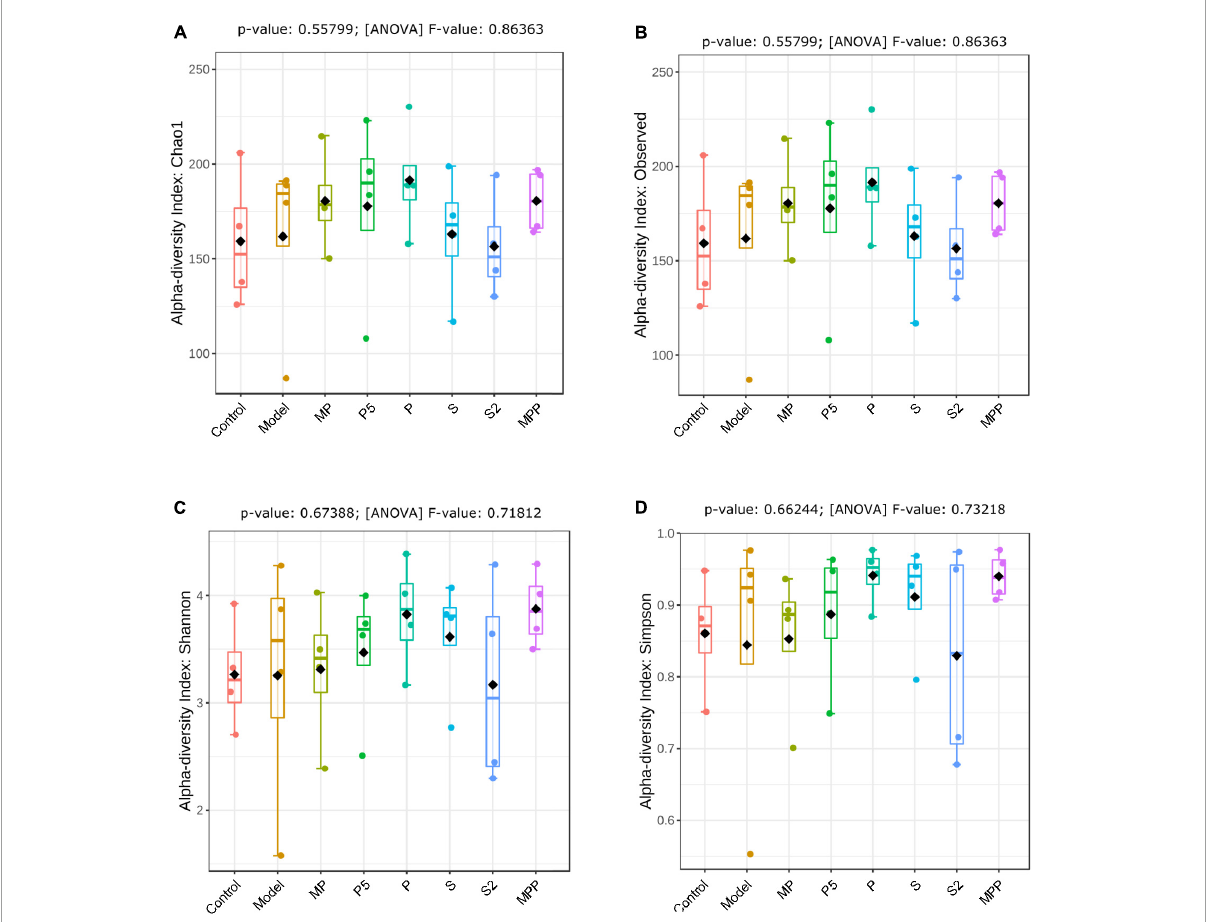
FIGURE4 The differences in (A) Chao1 index, (B) observed OTUs, (C) Shannon index, and (D) Simpson index of fecal microbiome among groups. Results were compared by one-way ANOVA and Dunnett’s multiple comparison